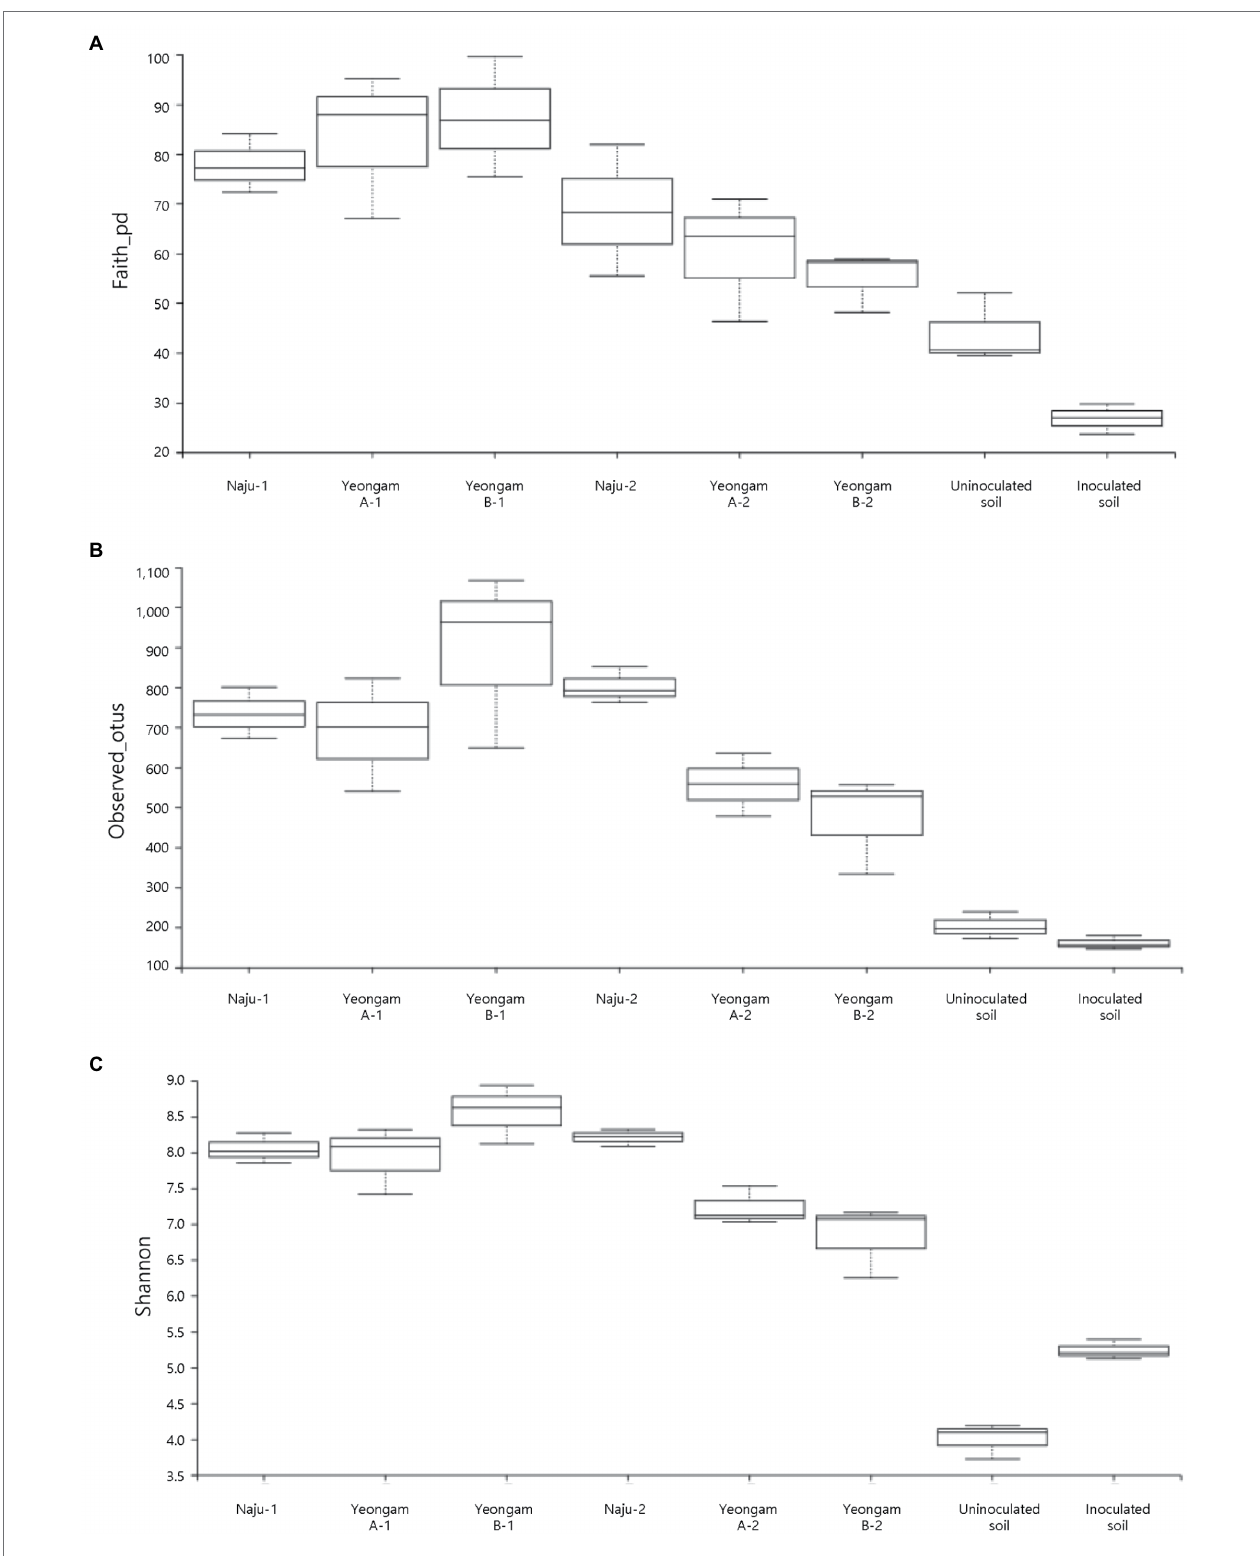
FIGURE 3 | Archaea, bacteria, and eukaryote richness and diversity indices of the three regions and inoculated soil. (A) Faith’s PD index. (B) Observed OTUs. (C) Shannon index. The box graph indicates the interquartile range. The line across the box depicts the median. 1 and 2 indicate before planting and harvest,